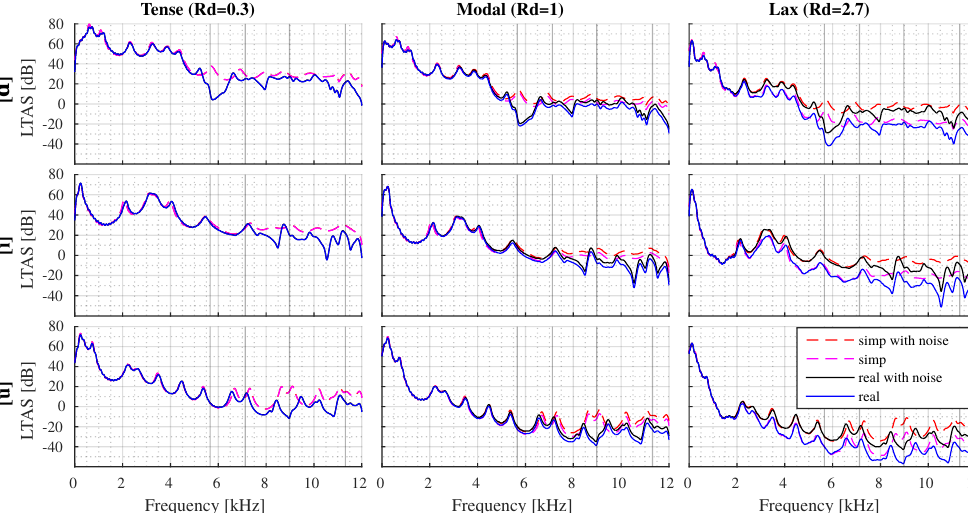
Figure 4. Long-term average spectra (LTAS) of the FEM synthesised vowels [ A ], [i], and [u] using the realistic and simplified vocal tract geometries with and without aspiration noise. Vowels were generated with a tense ( R d = 0.3), a modal ( R d = 1), and a lax ( R d = 2.7) phonation with F 0 = 120 Hz. Vertical lines depict the boundaries of the 1/3 octave bands 6.3 kHz, 8 kHz, and 10